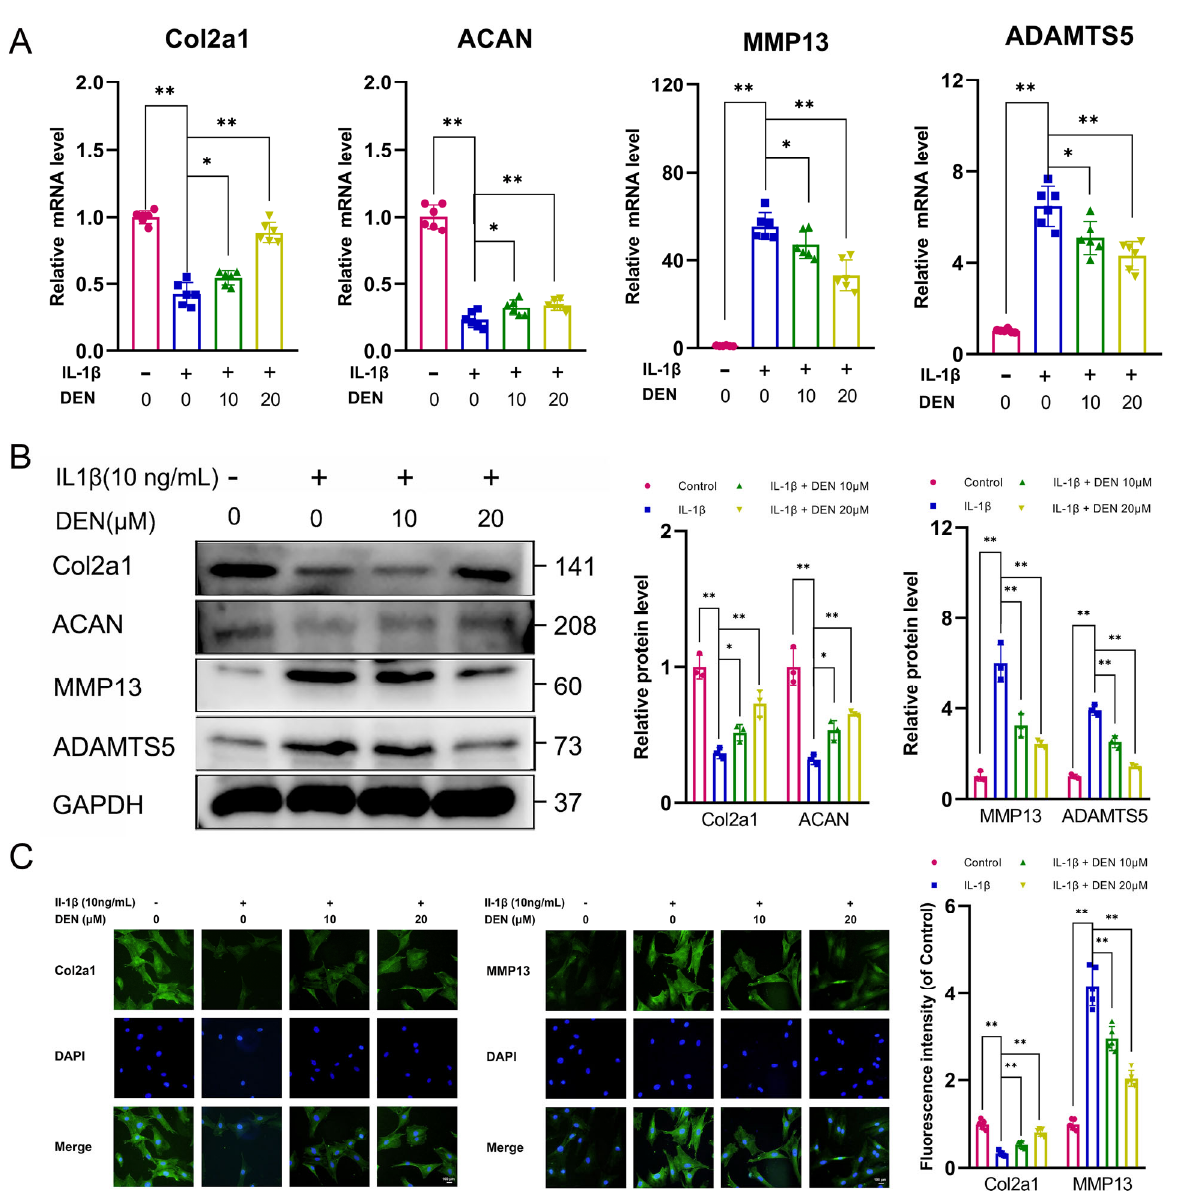
Figure 2. Effects of dendrobine (DEN) on extracellular matrix synthesis and degradation in IL-1 β -induced chondrocytes. ( A ) The expression levels of Col2a1, aggrecan (ACAN), MMP13, and ADAMTS5 were shown in the results of RT-qPCR, n = 6. ( B ) The protein levels of Col2a1, ACAN, MMP13, and ADAMTS5 were presented by Western blotting, n = 3. ( C ) The expression of Col2a1 and MMP13 was detected by immunofluorescence using rat chondrocytes. n = 5. The values presented are the means ± SD. * p < 0.05, ** p <